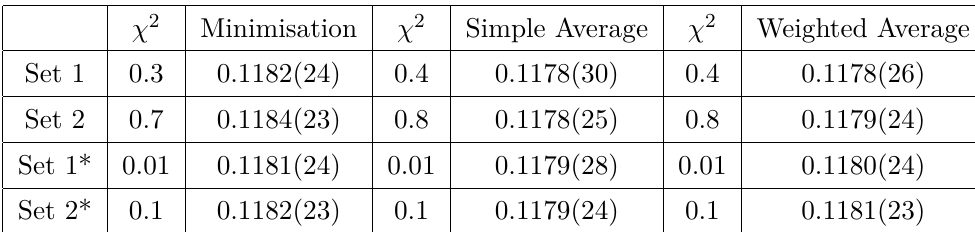
Table 13 . Averaged results for α ( n f =5) s ( M 2 assumed to be